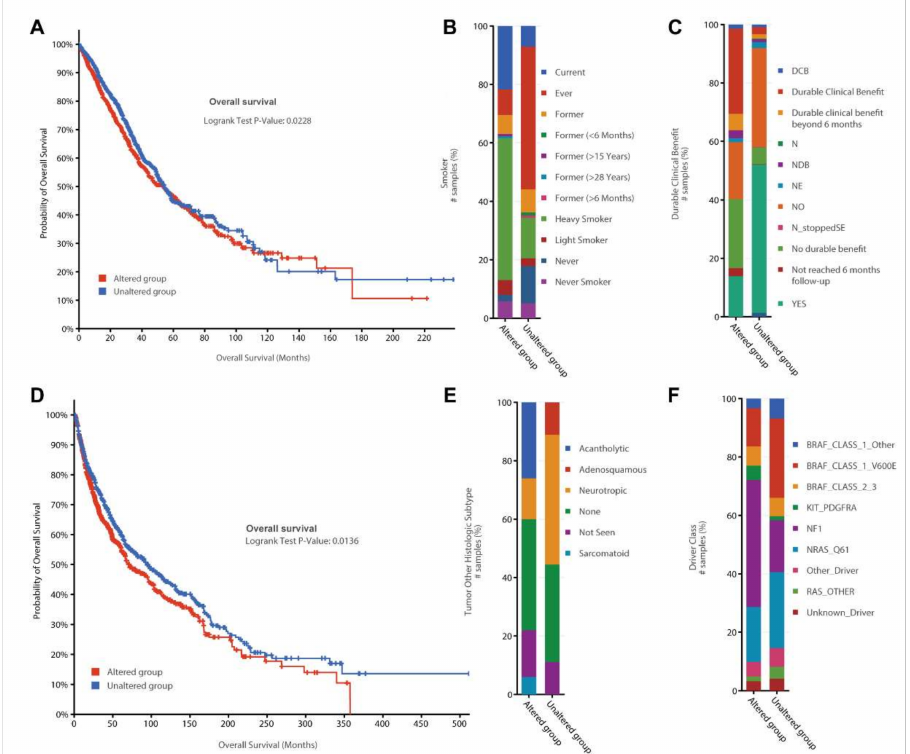
Figure 4. The survival and clinical feature analyses for the 39 stably expressed neuropeptides and receptors in 23 lung cancer studies ( A – C ) and 18 skin cancer studies ( D – F ). ( A ) The Kaplan–Meier curves show the overall survival months for 6310 lung cancer patients with specific mutations (red) and no mutations (blue) in 39 genes. ( B ) The stacked bar chart shows whether or not each of the 6310 samples smoked. ( C ) A stacked bar chart depicts long-term clinical benefits distribution in 6310 lung cancer samples. ( D ) The Kaplan–Meier curves show the overall survival months for 1063 skin cancer samples with specific mutations (red) and no mutations (blue) in the 39 genes. ( E ) The histological subtypes for all 1063 samples are summarized in the stacked bar chart. ( F ) A stacked bar chart shows how the driver mutations in 1063 skin cancer samples were